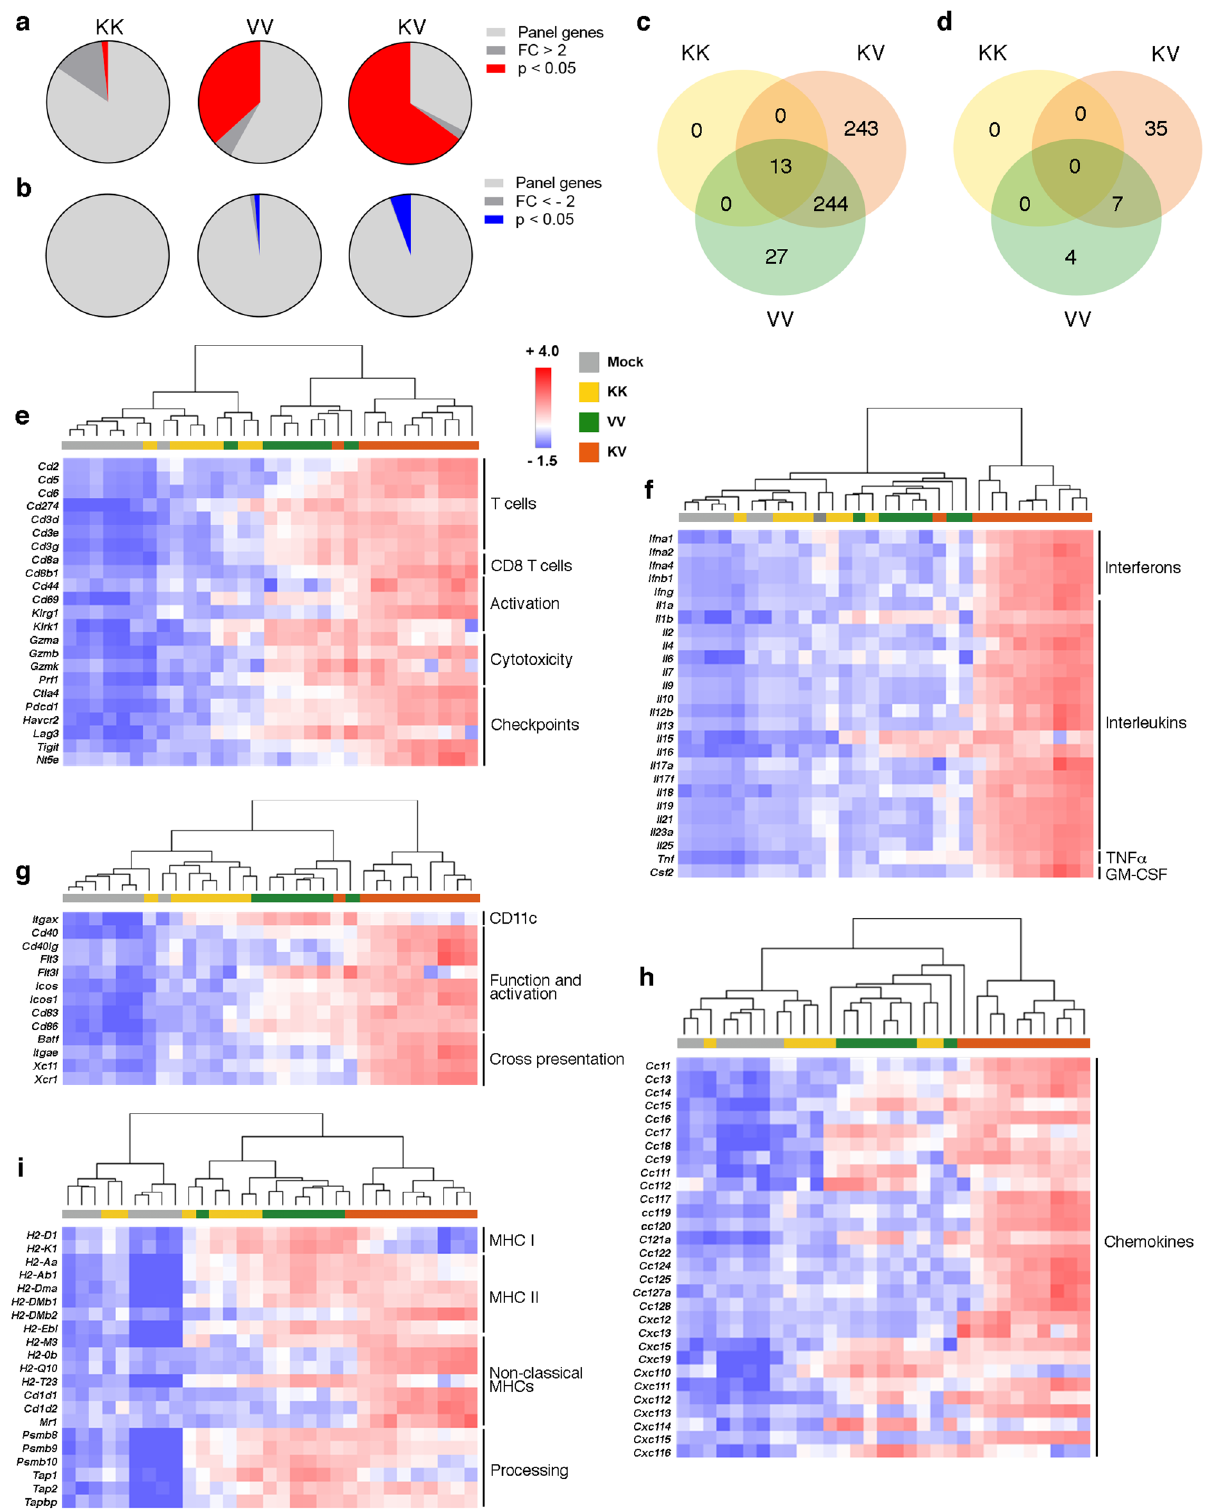
Ef fi cacy and synergy with checkpoint blockade . Susceptibility to oncolytic viruses varies between tumors, and continued viral propagation is often limited. Heterologous prime-boost with oncolytic vaccines may address such limitations in tumors with known antigenic targets. Hence, heterologous KISIMA-TAA/ VSV-GP-TAA prime-boost was assessed in a selection of